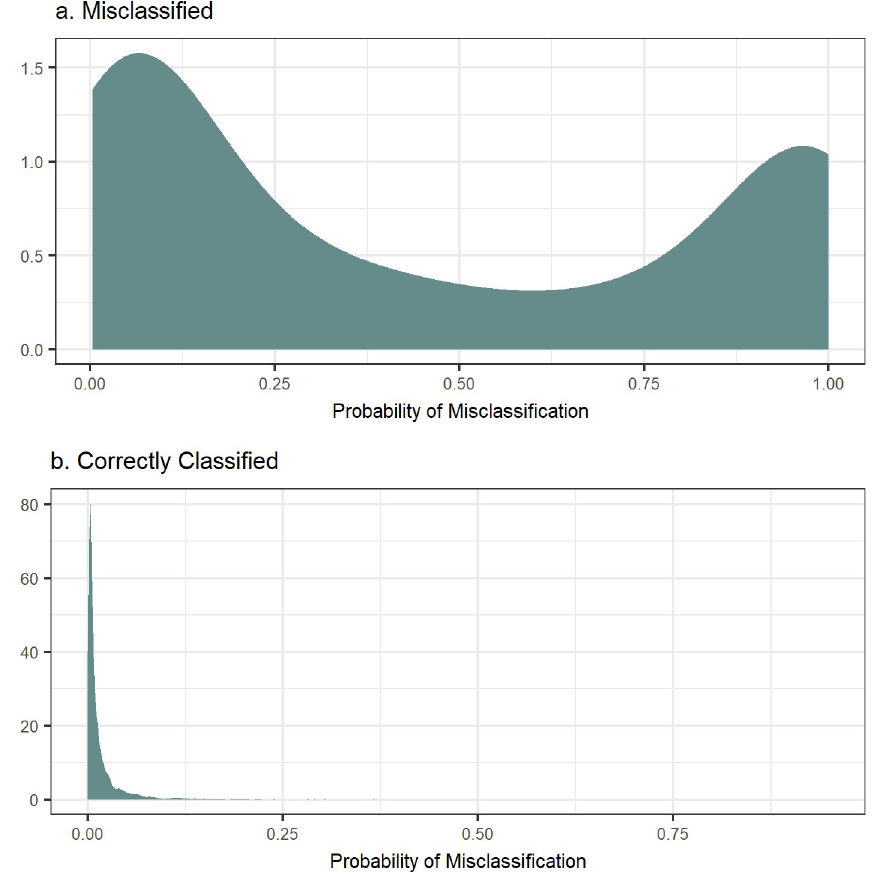
Fig 1. Misclassification probability densities for the a. miscoded observations and b. correctly coded observations.